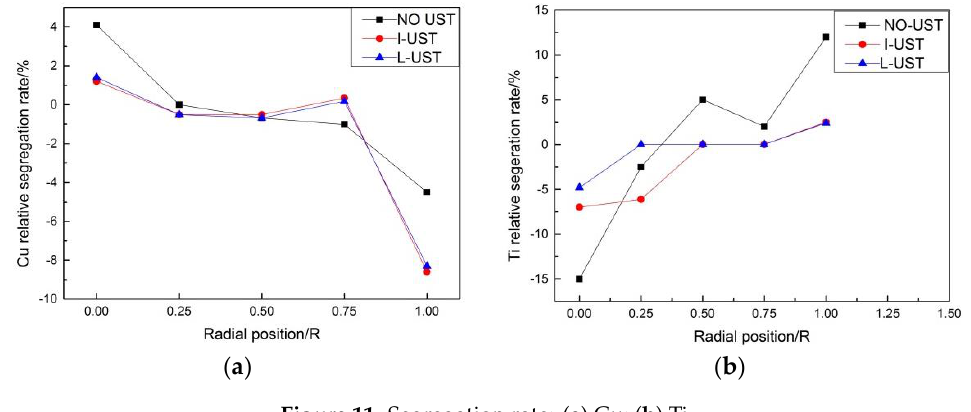
Figure 11. Segregation rate: ( a ) Cu; ( b ) Ti.